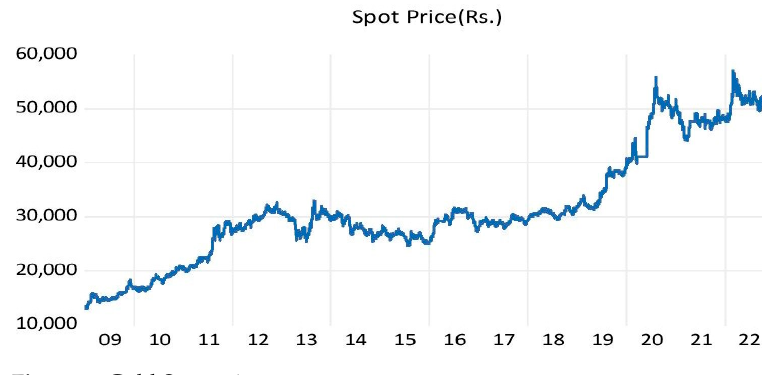
Figure 1. Gold Spot price.